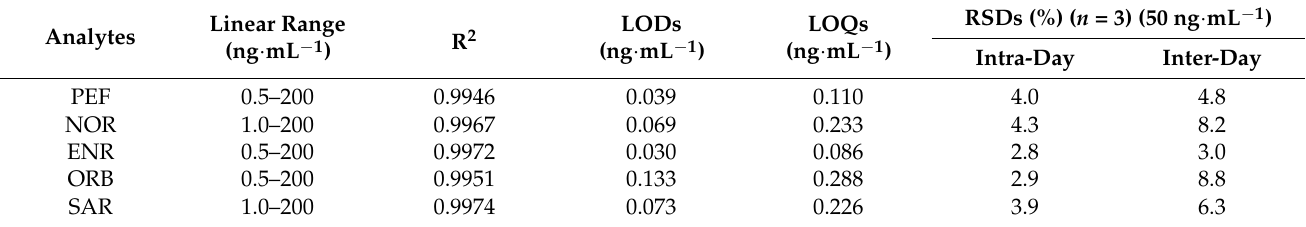
Table 1. Characteristic data for the dSPE with PAN/TpPa–1 nanofiber as sorbent for the subsequent HPLC